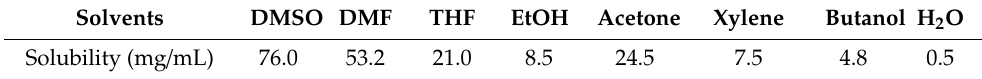
Figure 4. Solubility experiments of aniline tetramer in di ff erent solvents. Table 2. Solubility of aniline tetramer (AT) in commonsolvents.